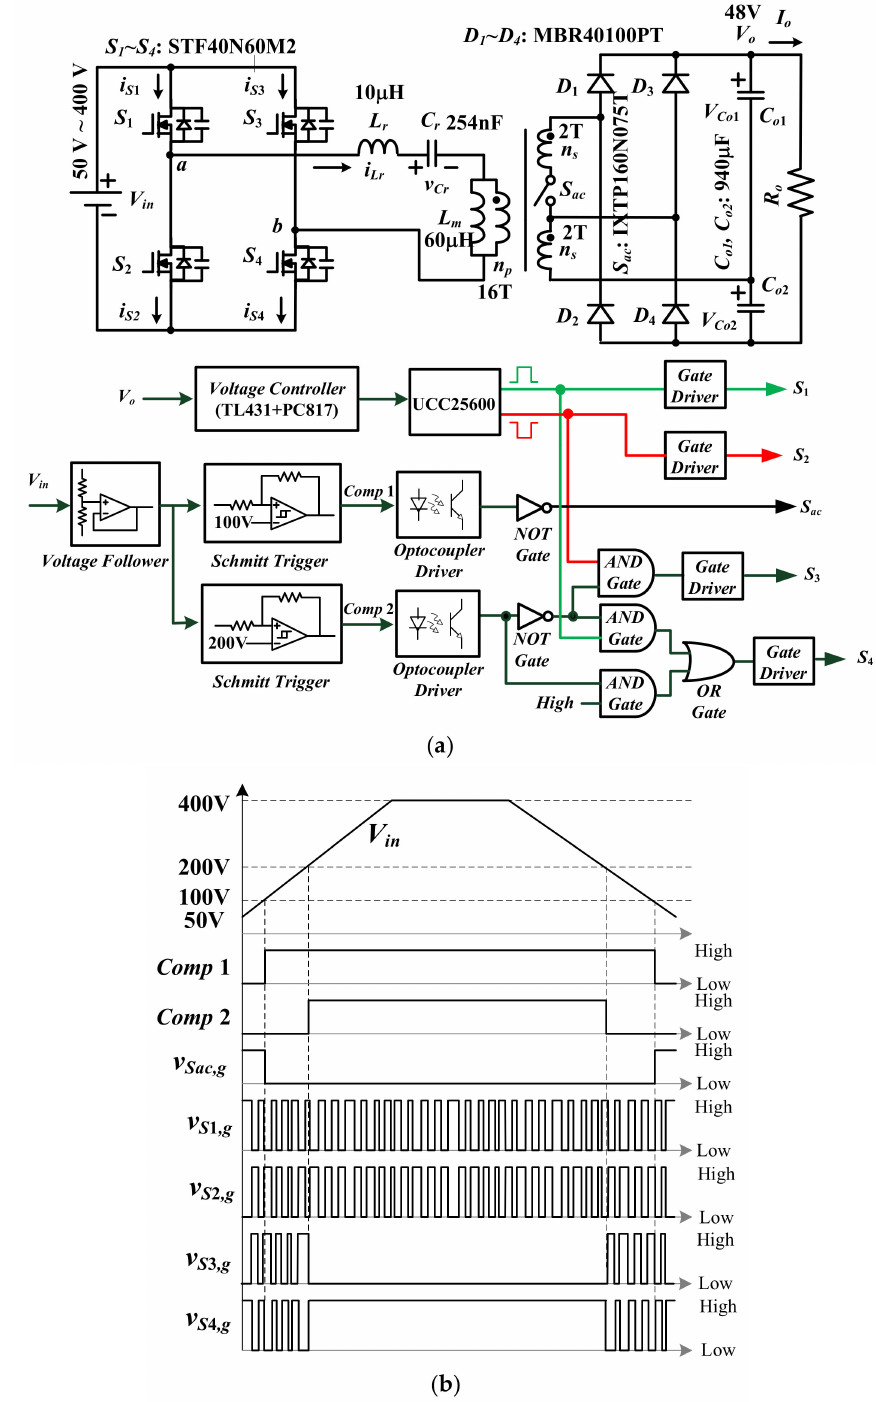
Figure 7. Laboratory prototype: ( a ) circuit diagram and control block; ( b ) control signal and input